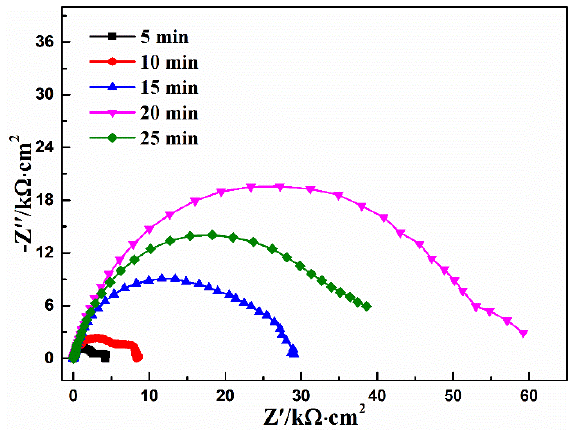
Figure 3. Experimental Nyquist plots of coated AZ91D samples obtained from different conversion times.